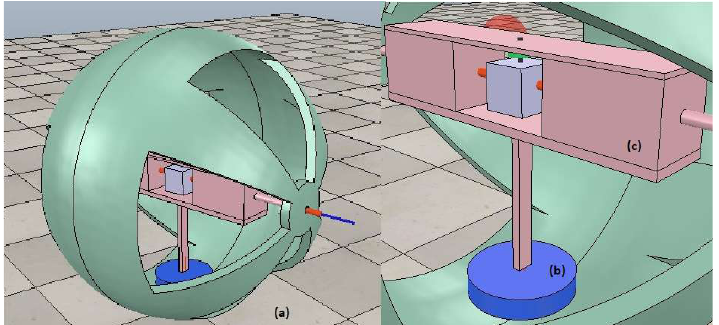
Figure 1. Model of the spherical robot in the simulation: ( a ) Spherical robot. ( b ) Pendulum. ( c ) Elec- tronic